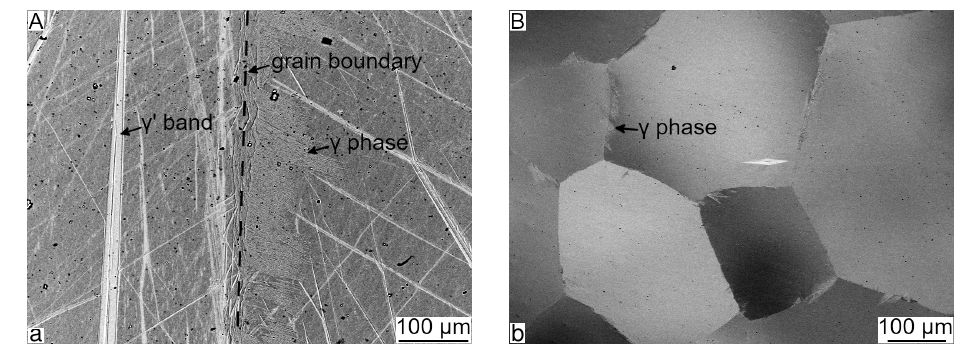
Fig. 2: Initial microstructures of materials A and B containing γ phase at the grain boundaries and regions of transformed phase ( γ (cid:48) ). The loading direction is horizontal.